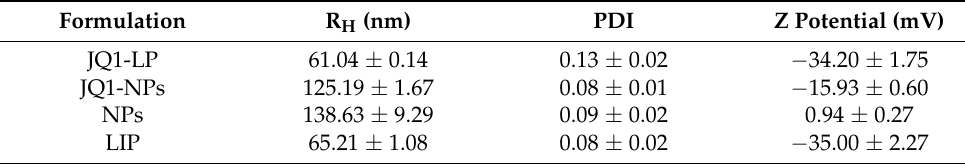
Figure 1. Formulation and morphology of JQ1-LP and JQ1-NPs. ( A ) Schematic formulation of nanodevices. ( B ) SEM images of nanodevices (scale bar = 1 μ m). ( C ) TEM images of nanodevices (scale bar = 100 nm). Table 1. Characterization of loaded and non-loaded nanodevices.